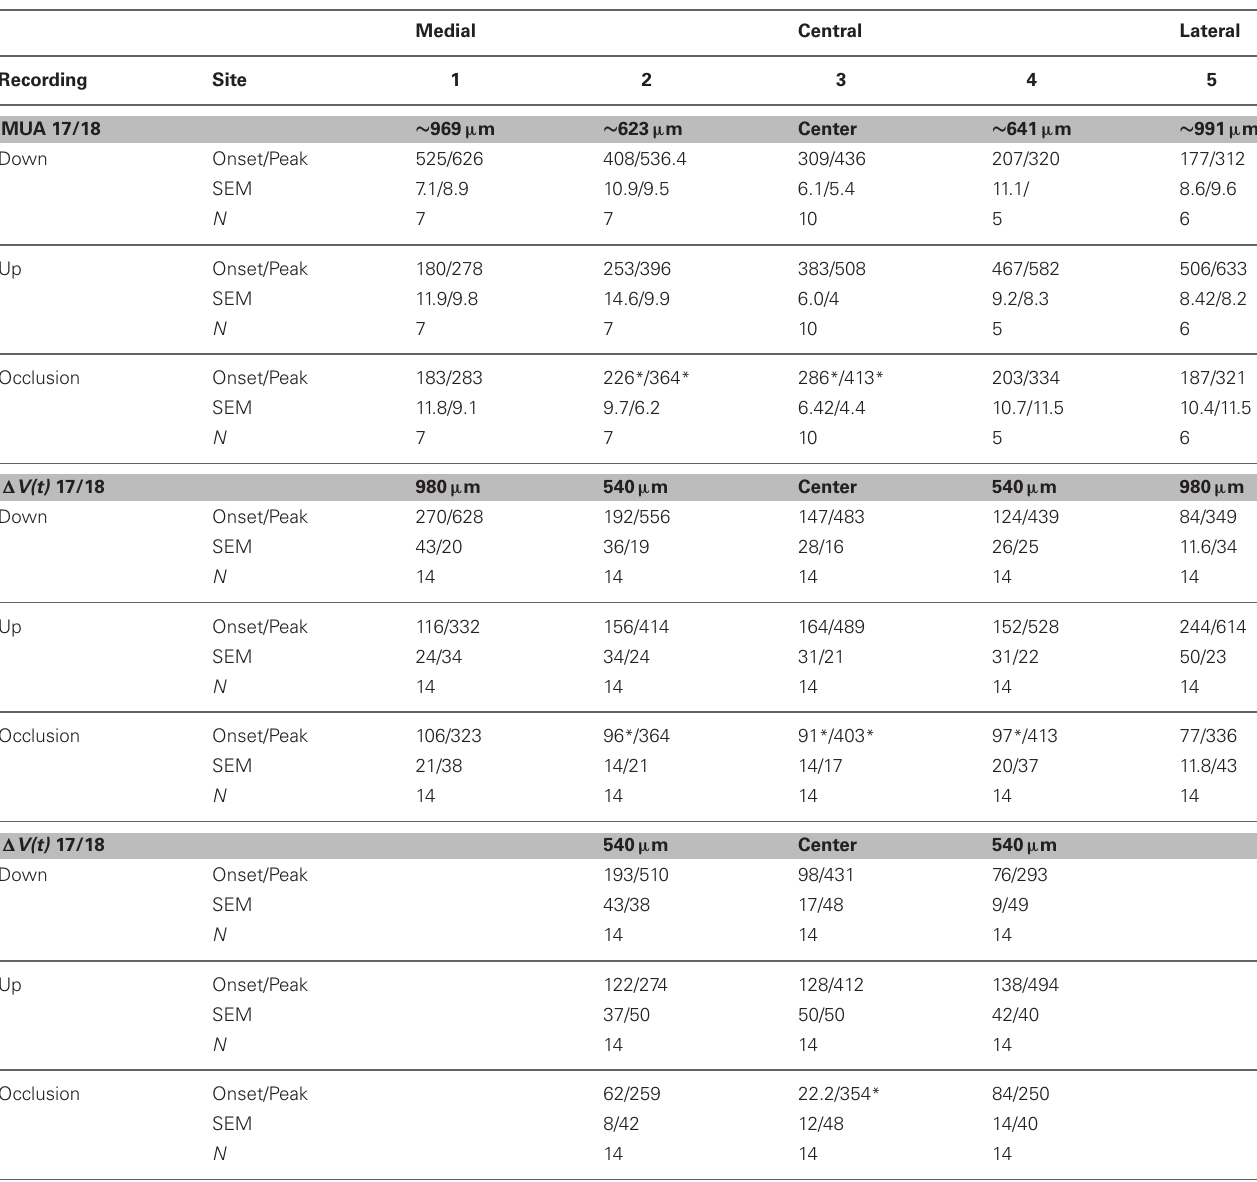
Table 1 | Onsets and peaks of multiunit activity and dye signal. Medial Central